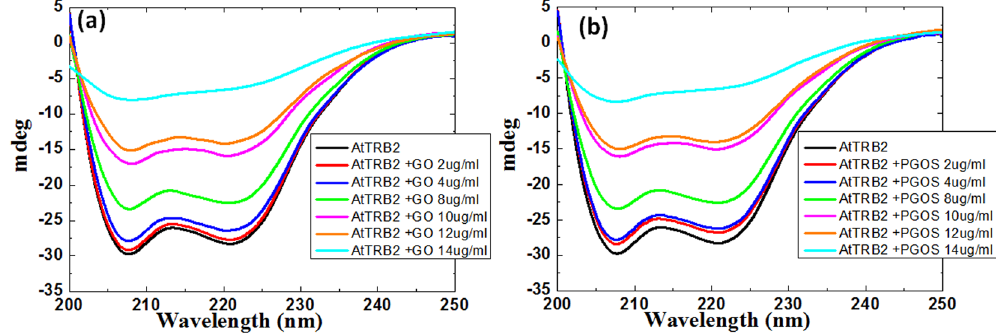
Figure 4. Secondary structure analysis using CD spectroscopy of AtTRB2 protein after treatment with ( a ) GO at different concentration and ( b ) at different concentration of